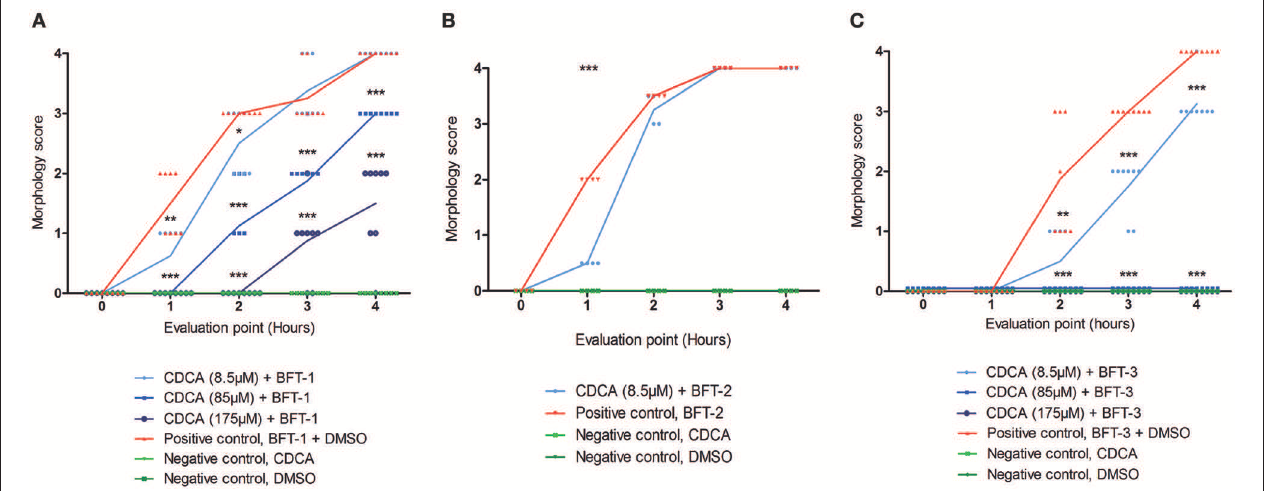
FIGURE 4 | Morphological inhibition of BFT-1, BFT-2, and BFT-3 by CDCA. BFT-1, BFT-2, and BFT-3 related morphology changes were inhibited by CDCA, where an increase in CDCA concentration correlated with increased inhibition for BFT-1 and BFT-3. Depending on measurement times, CDCA at a concentration of 8.5, 85, and 175 µ M resulted in 0–42%, 25–63%, and 73–100% inhibition of BFT-1 (A) . BFT-2 related morphology changes, only tested at a CDCA-concentration of 8.5 µ M, were reduced by 75% (B) . BFT-3 was inhibited by CDCA at a concentration of 8.5, 85, and 175 µ M with 25–73%, 100%, and 100% inhibition, respectively, depending on